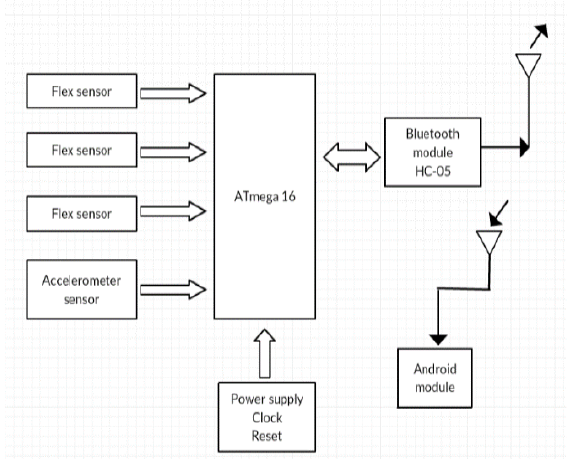
Figure 2: Block Diagram of the Components Mounted on Glove.